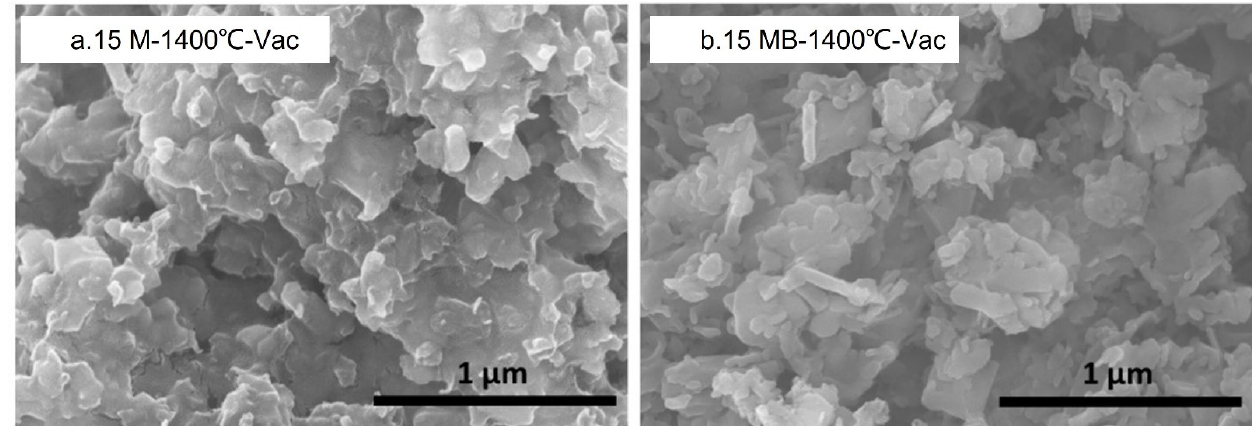
Figure 16. XRD spectra of the vacuum-treated products of the two kinds of precursors ( a ) 15 M and ( b ) 15 MB at different temperatures.